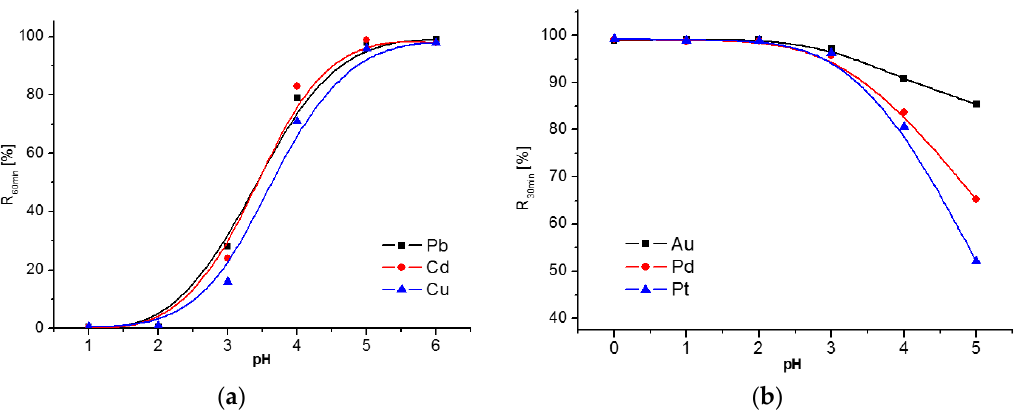
Figure 3. Effect of pH on the adsorption of Cu 2+ , Pb 2+ , and Cd 2+ monometallic solutions (10.0 μ g mL − 1 ) by DTC-g-PE-DA@GB@PU ( a ) and the adsorption of Pd 2+ , Pt 4+ , and Au 3+ monometallic solutions (1.0 μ g mL − 1 ) by PE-DA@GB@PU ( b ). Other conditions: adsorbent, 20 mg; shaking time: heavy metal ions 60 min, noble metal ions 30 min; and temperature, 25 °C.